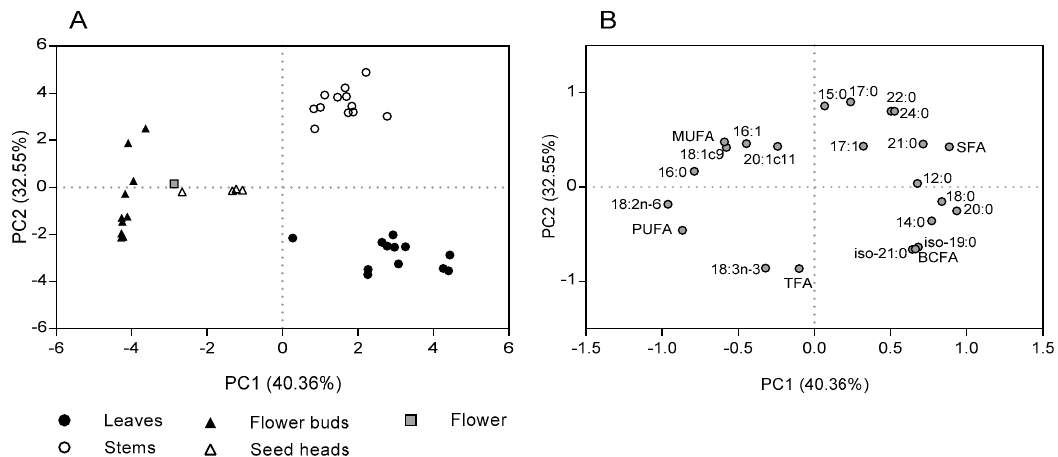
Figure 2. Scores ( A ) and loadings ( B ) of the two first principal components (PC) computed using the fatty acid content and composition of C. ladanifer morphological fractions.